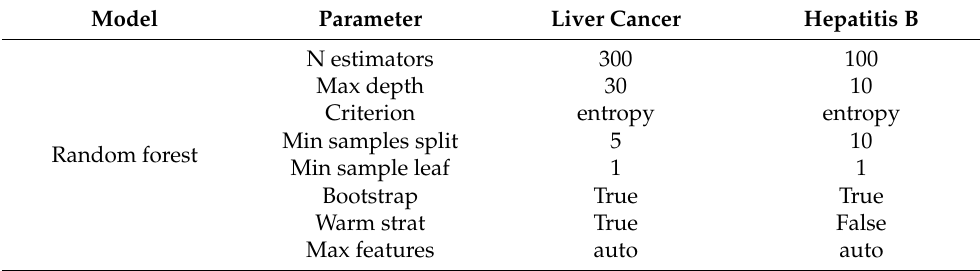
Table 2. List of optimized hyperparameters for the random forest.